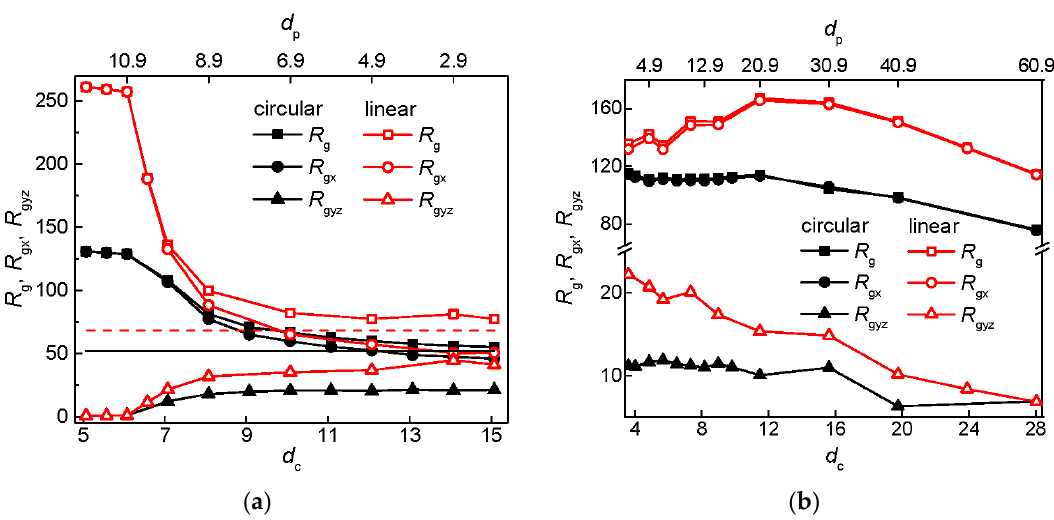
Figure 5. Radius of gyration and its longitudinal R gx and perpendicular R gyz components of a semiflexible circular and linear chain in an array of posts of varying diameter d p separated by S p = 12 ( a ) and with passage width w p = 2 ( b ) as a function of the size of the interstitial space. The solid and dashed horizontal lines in ( a ) denote the value of the radius of gyration of a corresponding free circular and linear chain, respectively.